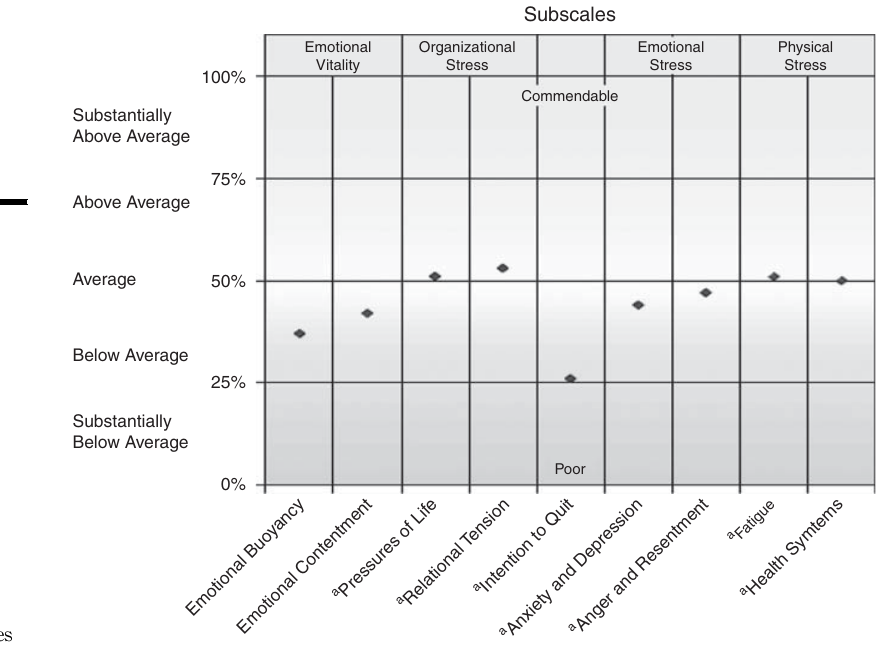
Figure 10. Associated